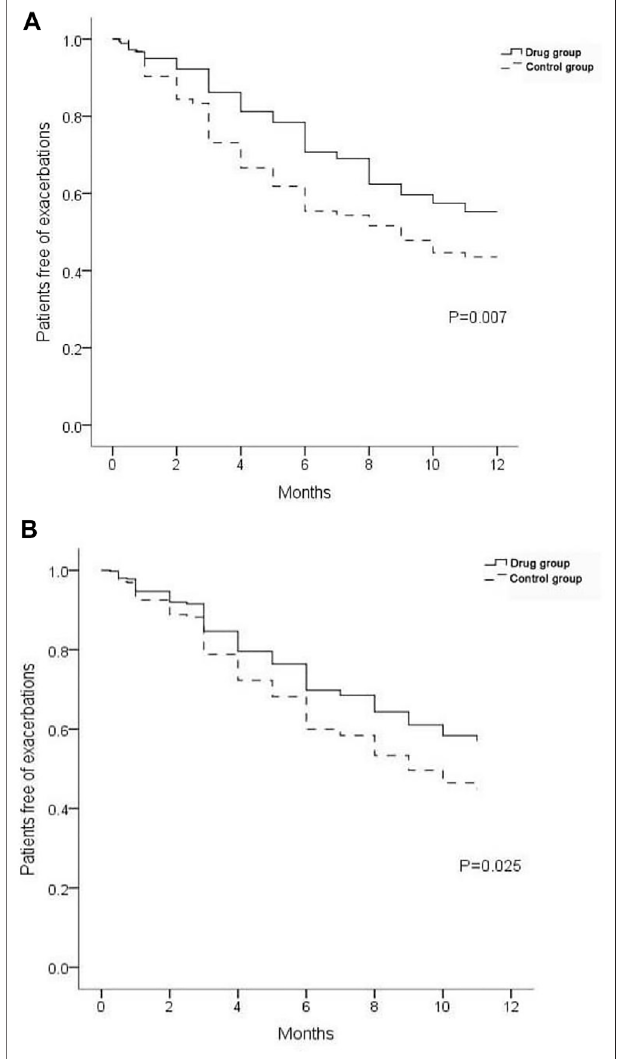
FIGURE5| Proportionofpatients freefromre-exacerbations. (A) Result of univariate analysis. (B) Result of multivariate Cox regression analysis.